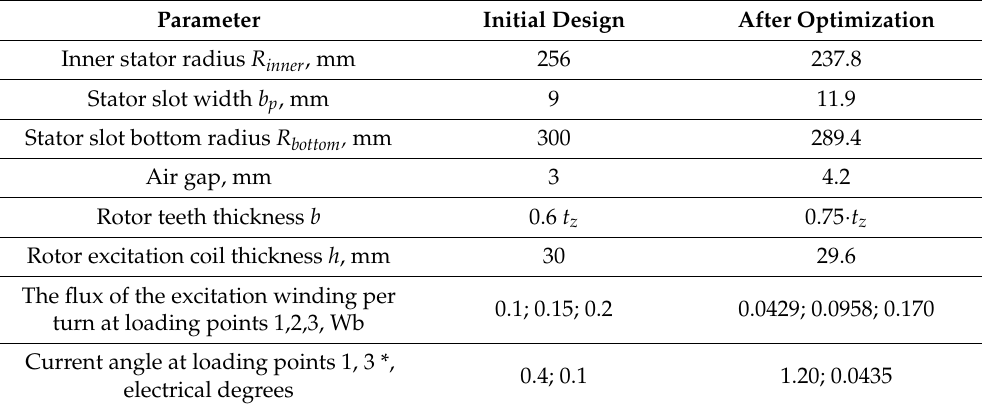
Table 3. WRSM parameters varied during optimization.